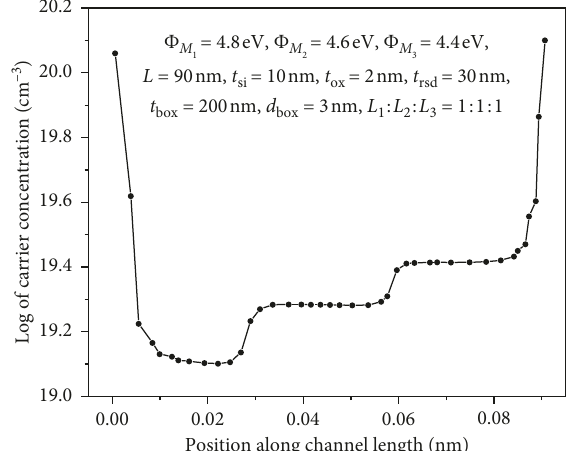
Figure 15: Carrier concentration along the position of channel length for TMG Re-S/D FD SOI MOSFET.